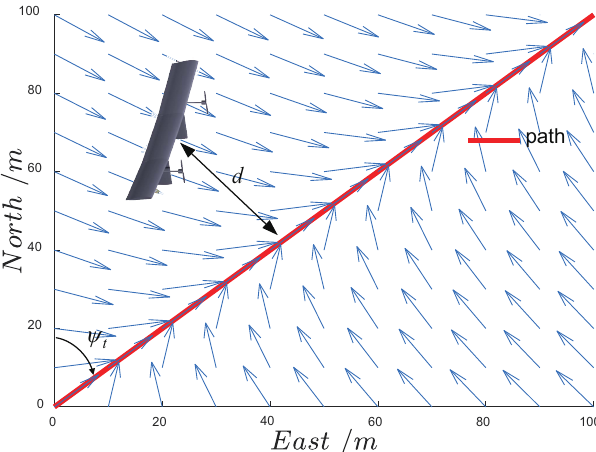
Figure 8. Schematic diagram of the lateral-directional trajectory tracking control law.